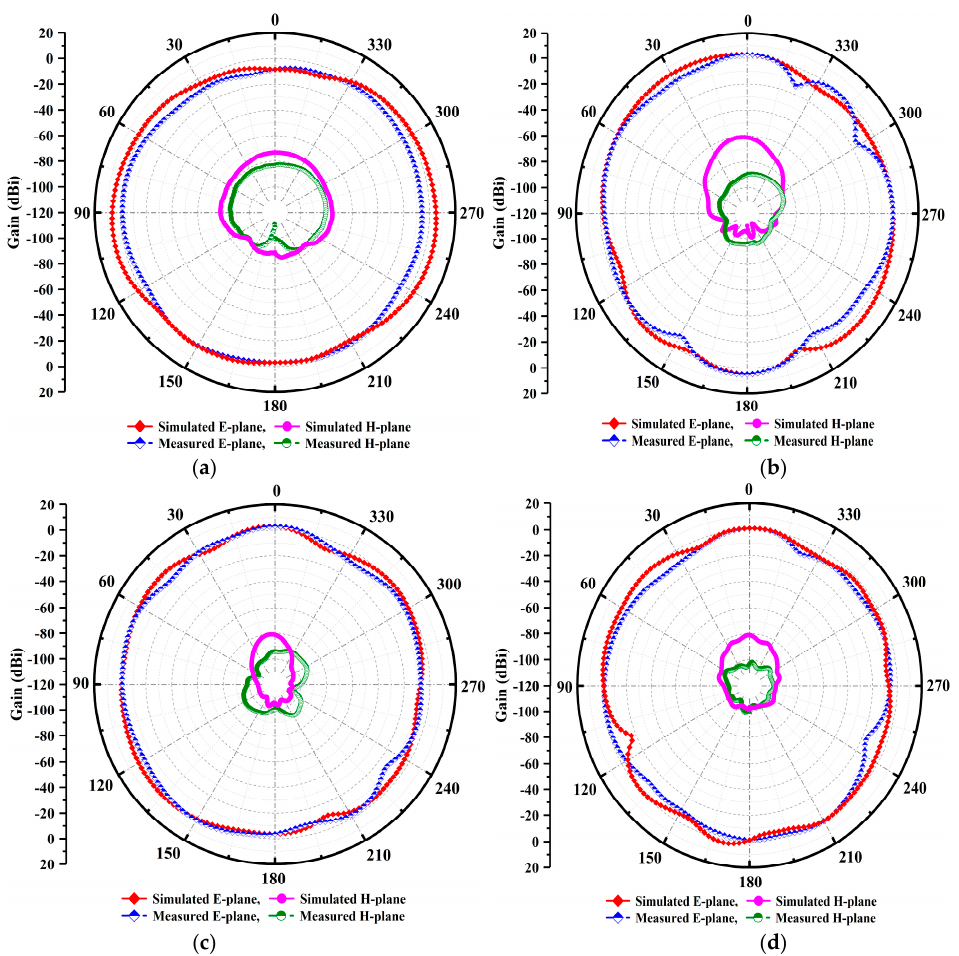
Figure 13. ( a – d ) Simulated and measured co-polarization and cross-polarization of E–H plane far-field patterns across the standard plane at multiple resonances.